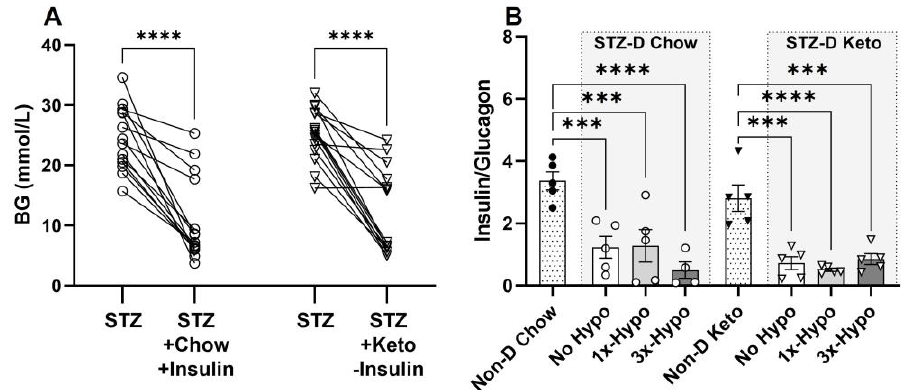
Figure 2. Streptozotocin (STZ) induces hyperglycemia and pancreatic damage in chow and keto-fed rats. ( A ) A single 60 mg/kg dose of STZ, administered i.p. significantly increased baseline BG levels in both Chow and Keto-fed rats; insulin supplementation decreased BG in the STZ-D Chow rats to the same level as ketogenic diet alone, without insulin supplementation, in STZ-D Keto group; ( B ) The ratio of insulin (β-cells)/glucagon (α-cells) producing cells in pancreatic islets of all STZ-D groups (No Hypo, 1 × -Hypo and 3 × -Hypo) of chow-fed and keto-fed rats was significantly reduced compared to vehicle (citrate) controls (Non-D Chow and Non-D Keto, respectively). Data were analysed by one-way ANOVA with Holm-Š í d á k multiple comparisons test and presented as mean ± SEM, *** p < 0.001, **** p <